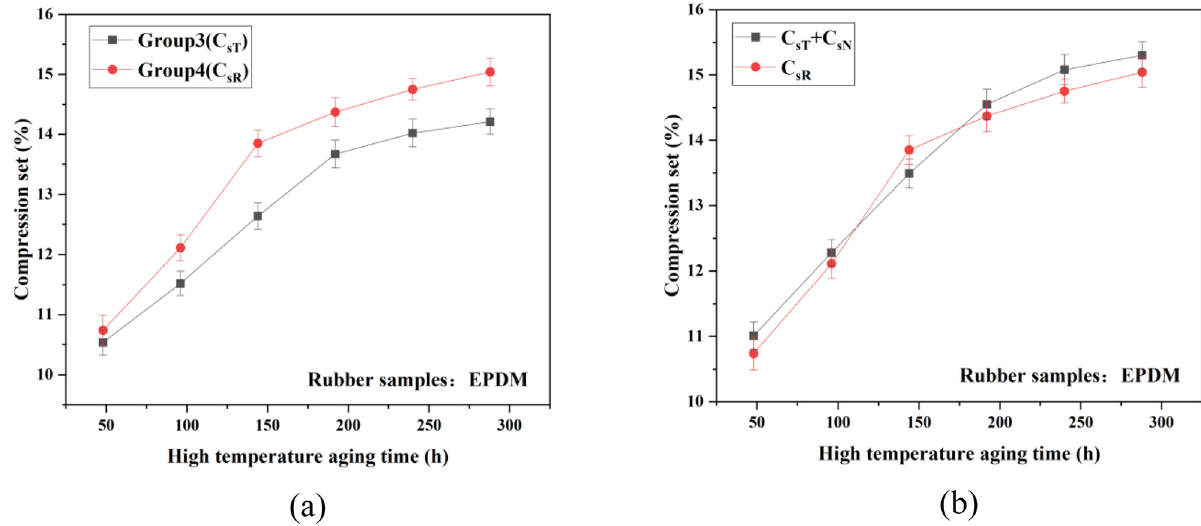
Figure 11: Compression set test results of EPDM of ( a ) C sT and C sR , and ( b ) C sT + C sN and C sR